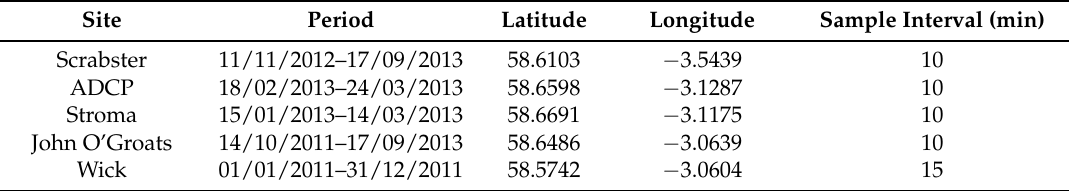
Table 1. Details of the sea surface height (SSH) data used for the model